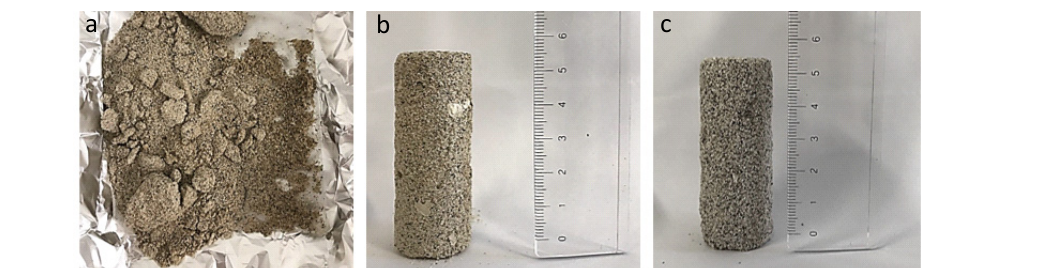
Figure 4. Biocementation of sand. (a) Control, (b) Biosandstone formed with P. chrysogenum MUM 9743 and (c) Biosandstone formed with N. crassa MUM 9802.